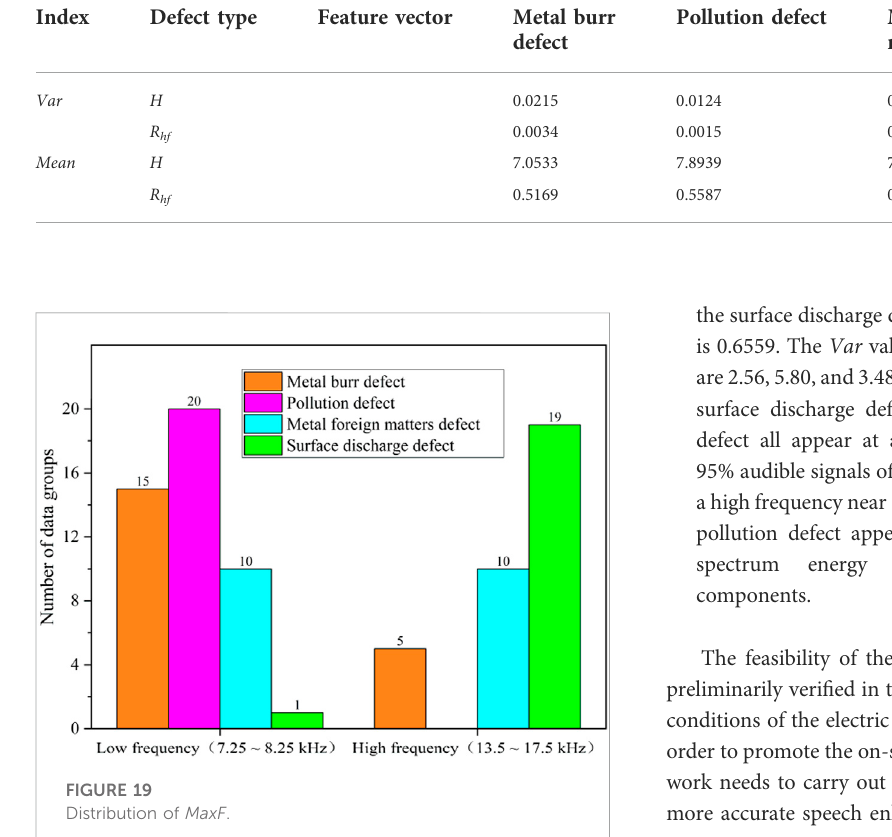
FIGURE 19 Distribution of MaxF